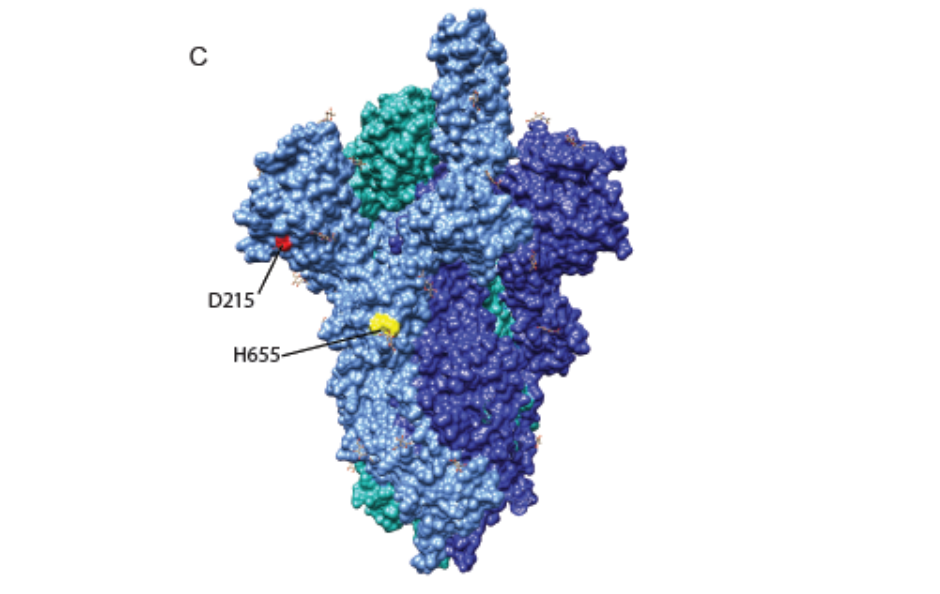
Figure 1. Viral evolution detected in rectal swabs in SARS-CoV-2 infected AGM. ( A ) AGMs were challenged via an intranasal and intratracheal route with SARS-CoV-2 using a stock of the WA1/2020 isolate harboring several variants relative to the patient sample. ( B ) Sequencing of viral RNA isolated from rectal swabs at 3–4 weeks after challenge revealed a consistent pattern of variants in all three animals. ( C ) Two spike mutations detected in all animals map to the N-terminal domain (D215G) and near the furin cleavage site (H655Y) based on a spike structure (PBD 7K8Z [26]).